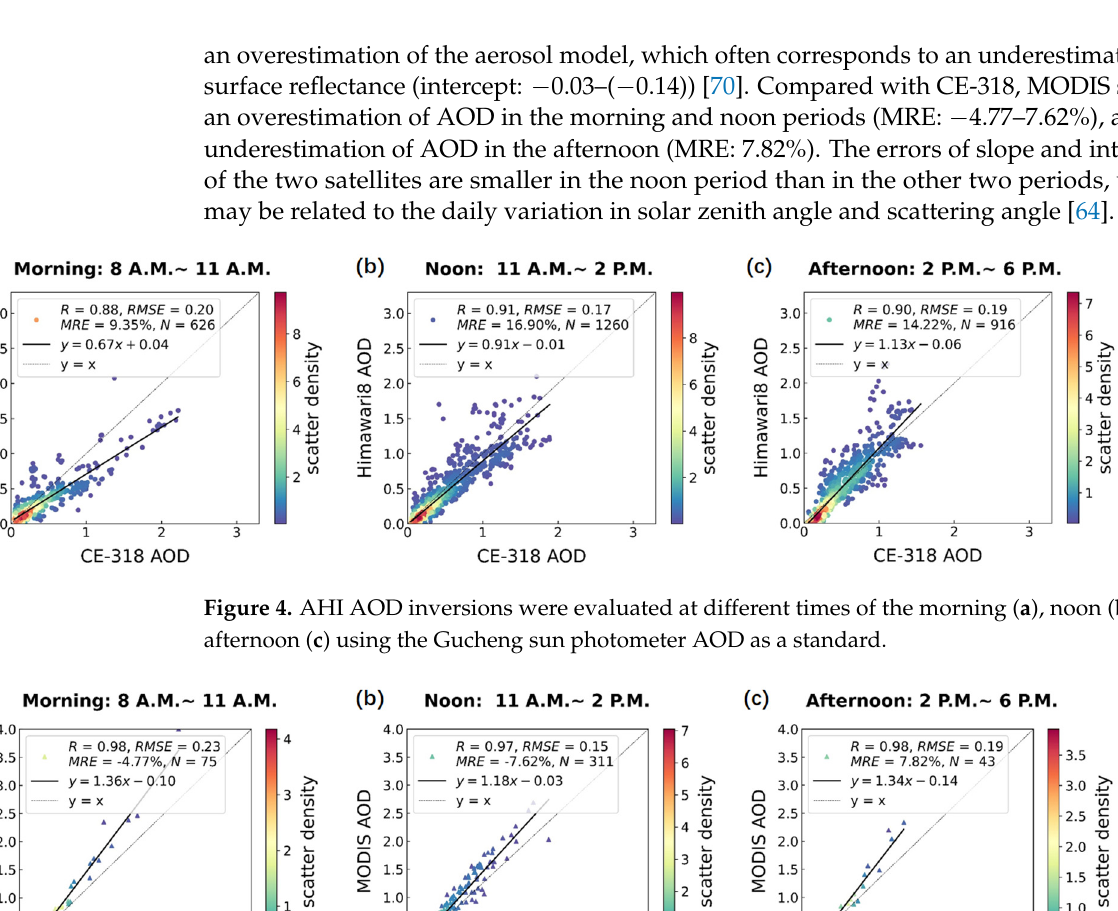
Figure 5. MODIS AOD inversions were evaluated at different times of the morning ( a ), noon ( b ), and afternoon ( c ) using the Gucheng sun photometer AOD as a standard.